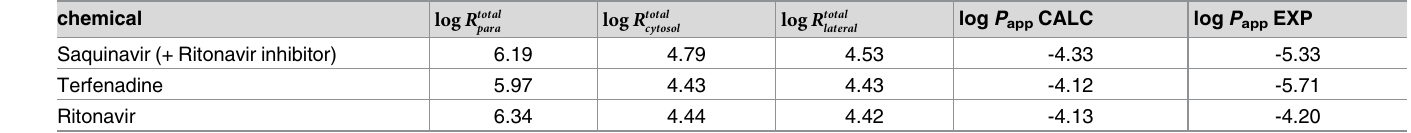
Table 1. List of chemicals for which the lateral route is predicted to have the highest permeability at pH 7.4.